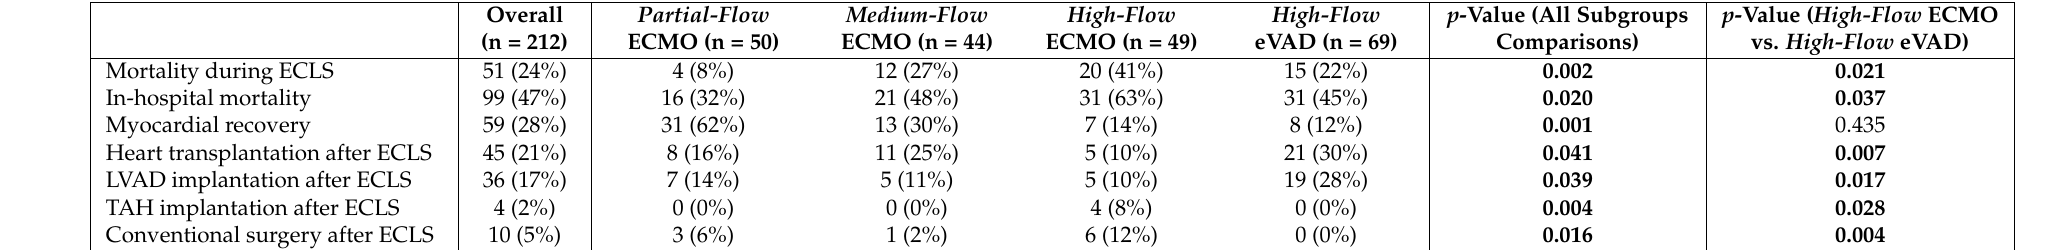
Table 4. Clinical